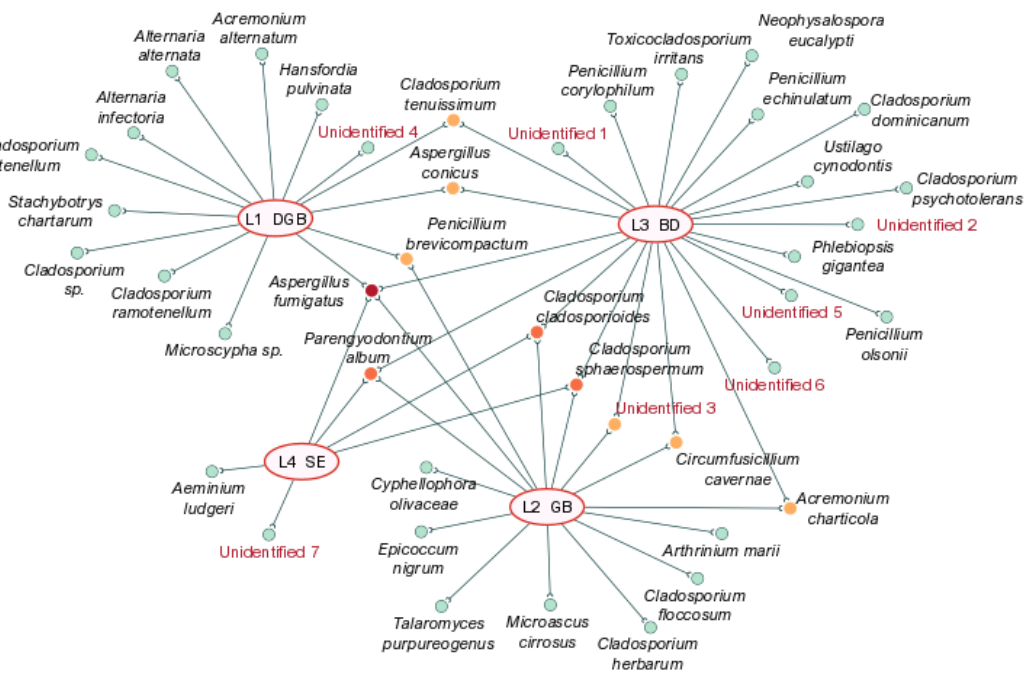
Figure 9. Network analysis showing the co-occurrence patterns of the cultivable species among sam- pling sites and their distinct biodeterioration patterns. sampling sites and their distinct biodeterioration